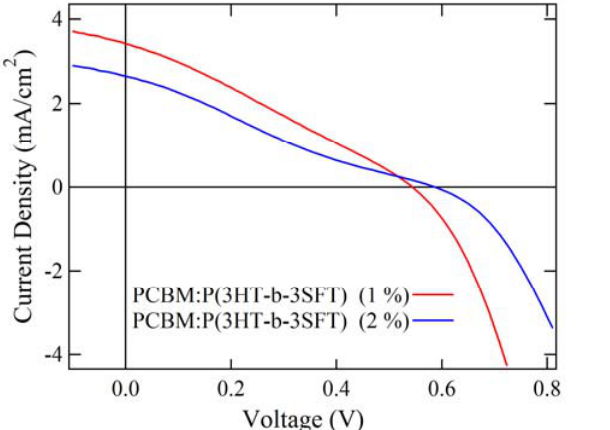
Figure 6. J - V characteristics of polymer solar cells with PCBM:P(3HT- b